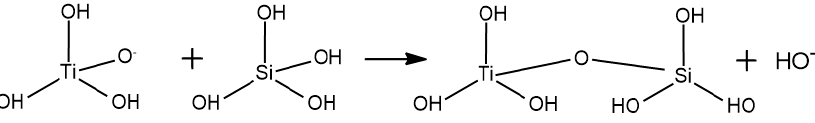
Figure A8. Hetero-condensation between Si(OH) 4 and Ti(OH) 4 molecules.